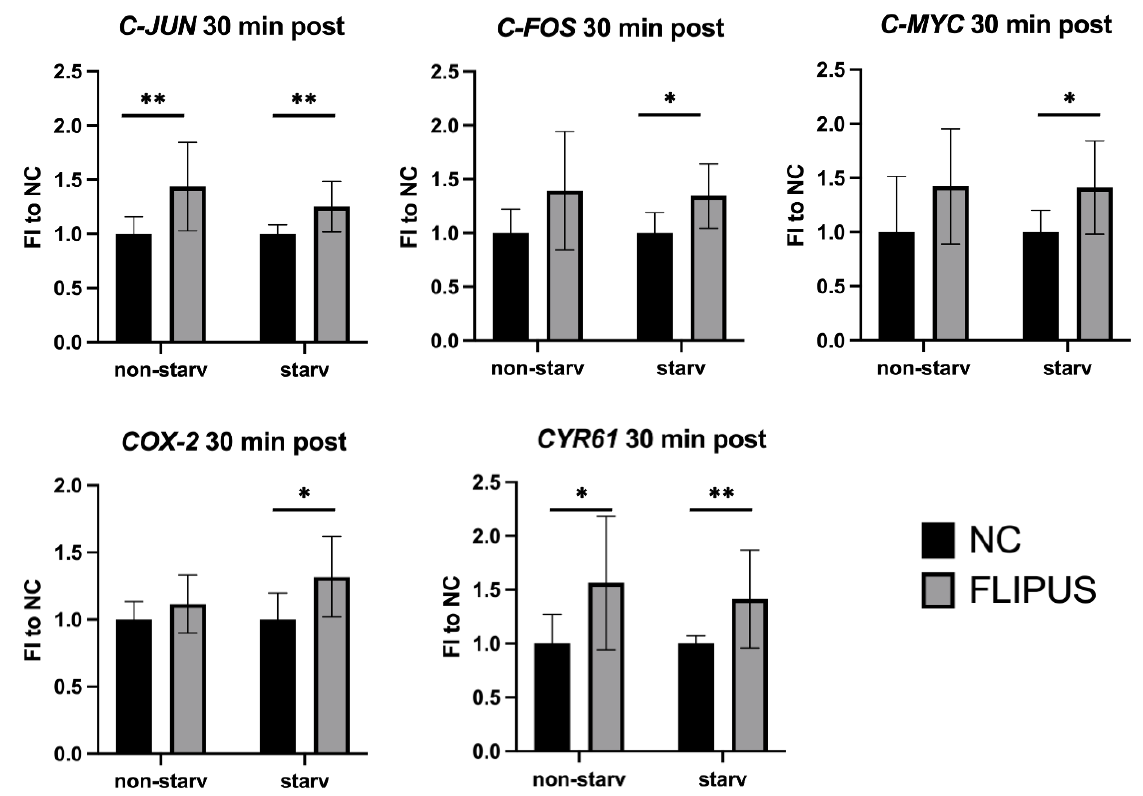
Figure 1. Expression of early-response genes after the 10 min FLIPUS mechanical stimulation of non-starved (non-starv) and starved (starv) MLO-Y4 osteocytes measured by qRT-PCR. Expression of the HPRT housekeeping gene was used as a relative control. FI to NC stands for fold induction over negative control, which did not receive ultrasound treatment. Each data point was the result of N = 4 and n = 2, where N and n are biological trials and technical replicates, respectively. * and ** represent p ≤ 0.05 and p ≤ 0.01, respectively.